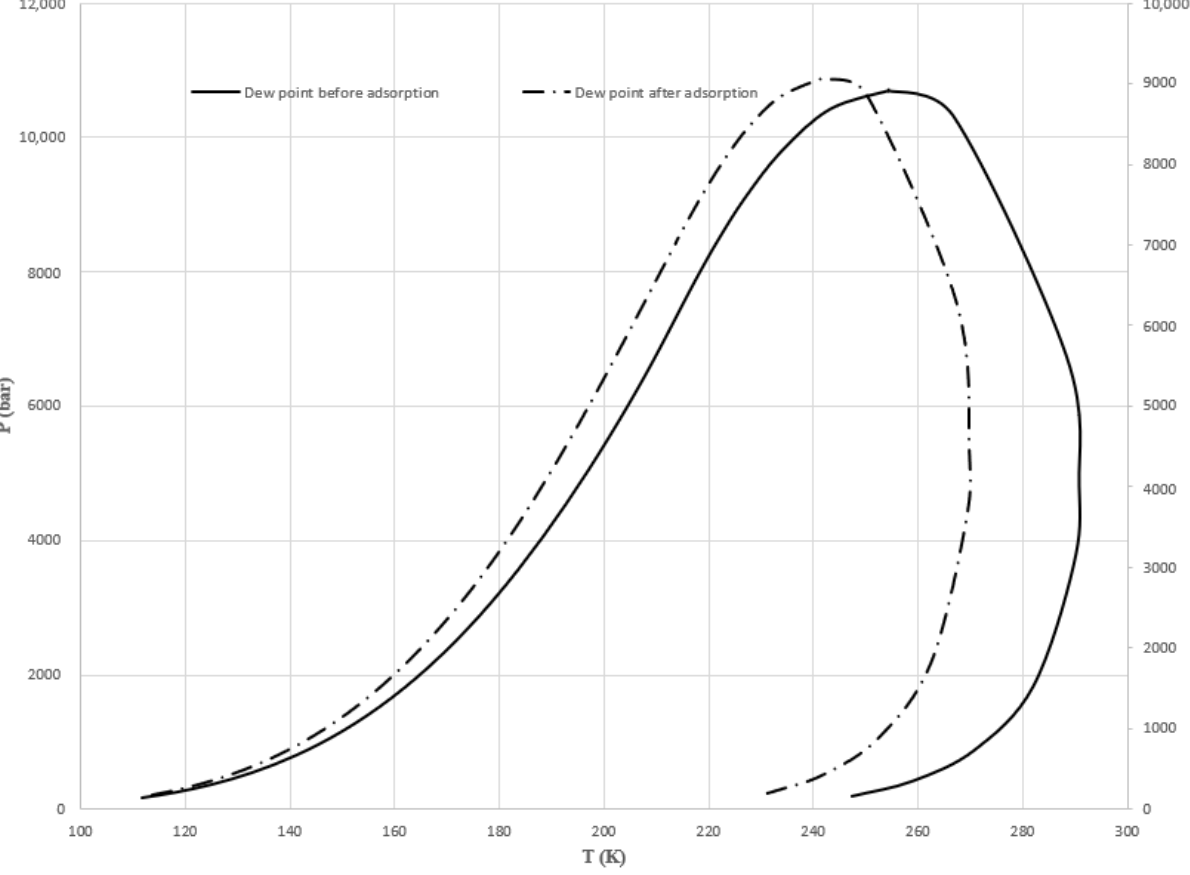
Figure 7. Water mole fraction in different zones of the bed with time.